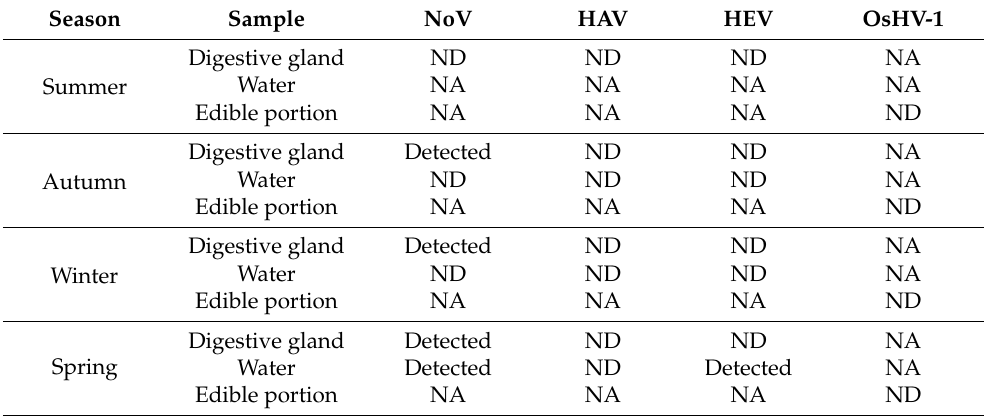
Table 6. Detection of norovirus (NoV) hepatitis A virus (HAV), hepatitis E virus (HEV), and oyster herpesvirus type 1 (OsHV-1) in sampled